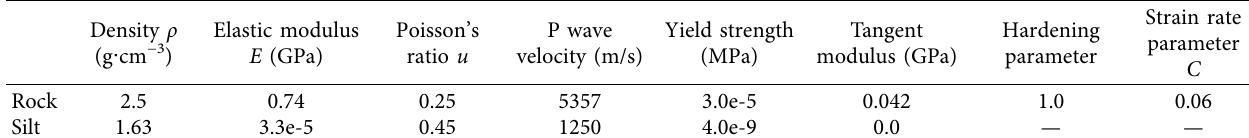
Table 2: Physical and mechanical parameters of rock and